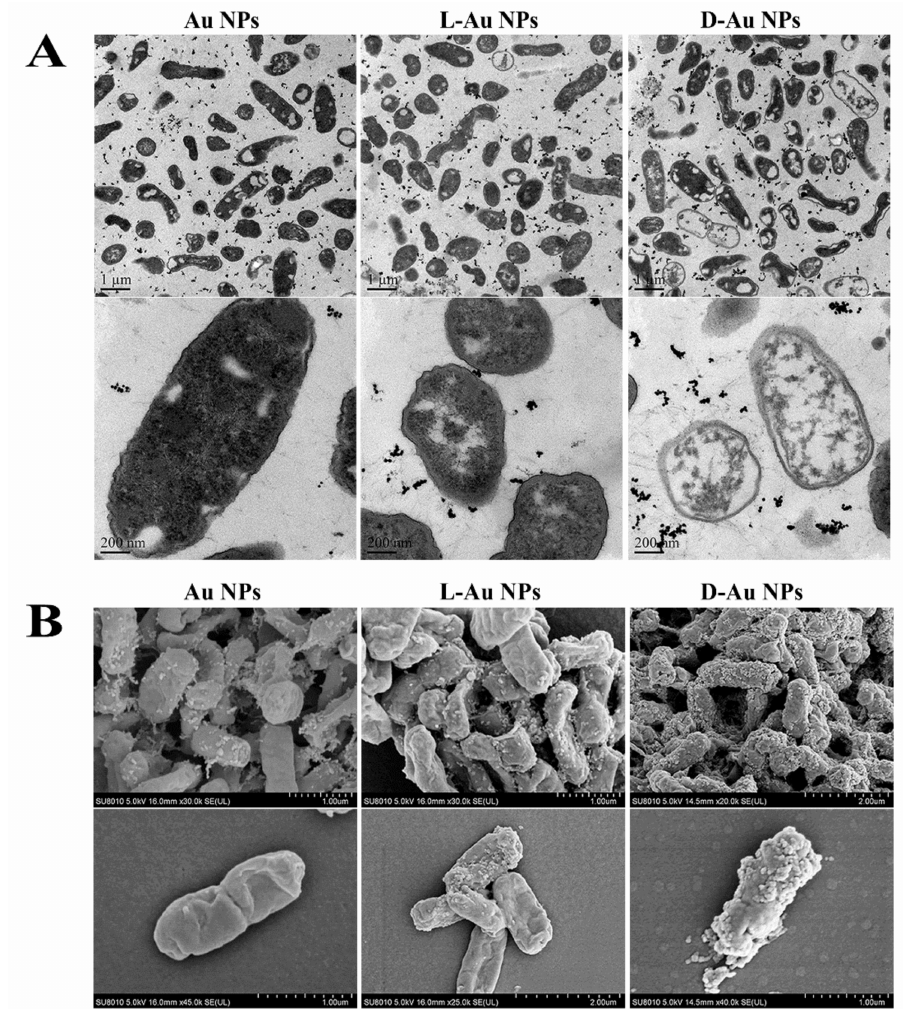
Figure 3. ( A ) TEM and ( B ) SEM images (5.0 kV for work) of E. coli after treatment with Au NPs, L -Au NPs and D -Au NPs for 12 h,